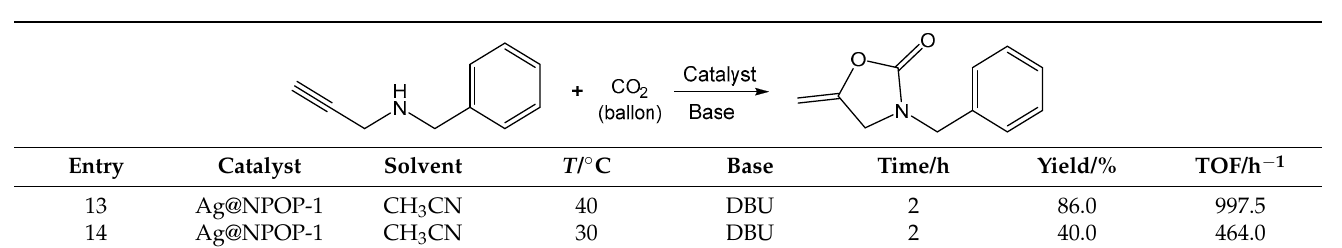
Table 1. Catalysis of NPOPs and Ag@NPOPs for the carboxylative cyclization of propargylic amines Table 1. Cont. with CO 2 a .